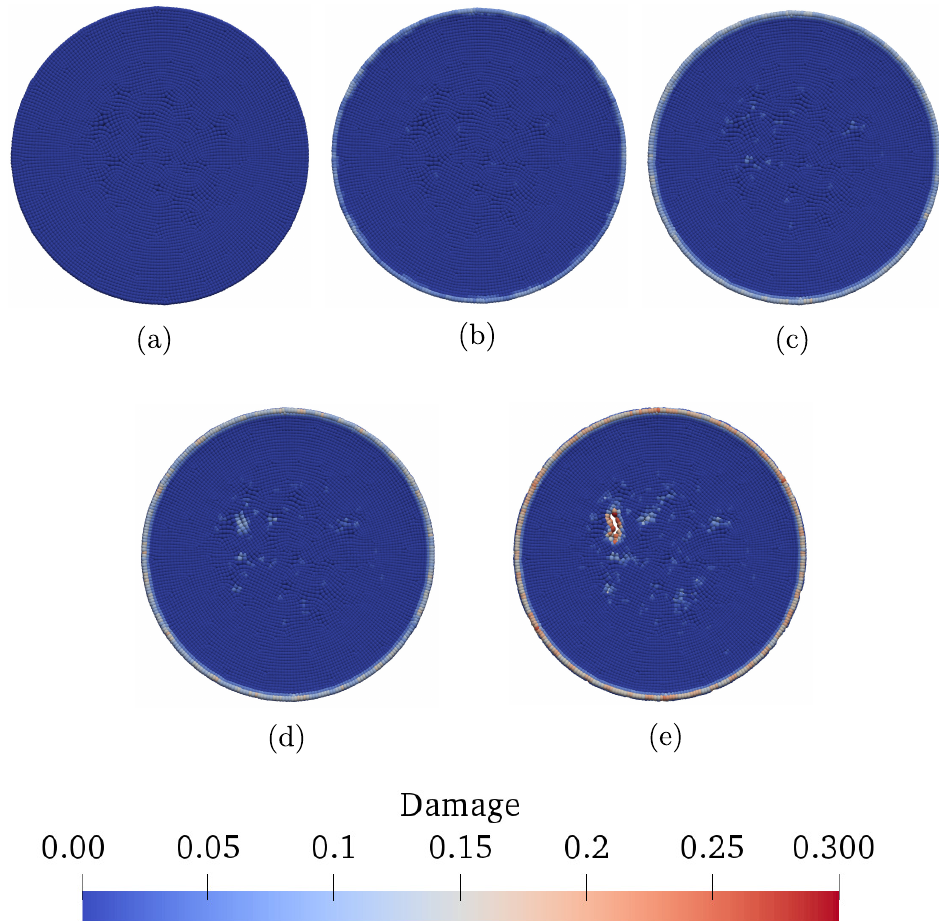
Figure 8. Snapshots of the contours of damage in the soil sample at 5 load steps: ( a ) Step 1; ( b ) Step 20; ( c ) Step 30; ( d ) Step 40; ( e ) Step 50, for δ = 3 mm. Note: The deformation is amplified by a factor of 20 for